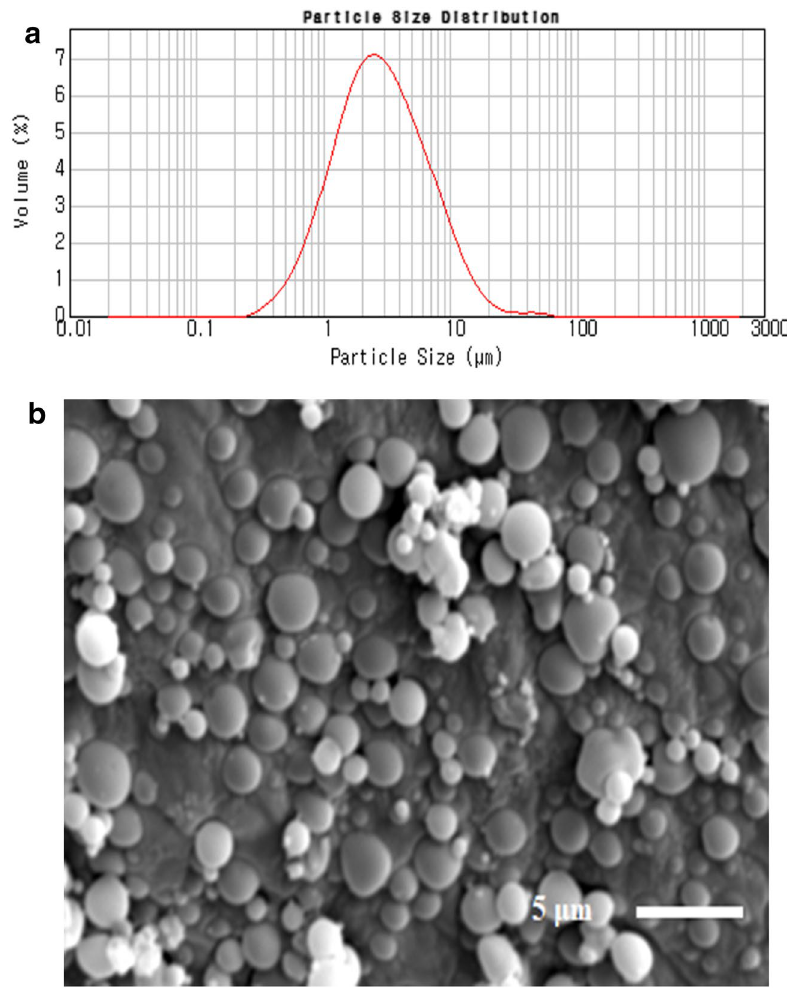
Figure 2. Morphologic and physical characteristics of TA-loaded PLGA microspheres. ( a ) Particle size distribution of TA-loaded PLGA microspheres prepared using spray drying technique. ( b ) Electron microscopy image of PLGA